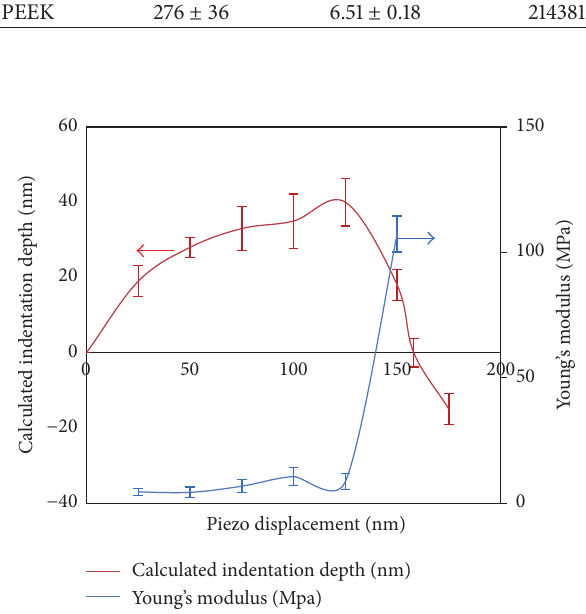
Figure 5: Indentation depth versus piezo displacement of SPEEK using the approach portion of the force curve via AFM and calculated Young’s modulus versus piezo displacement of SPEEK using the Hertz model.